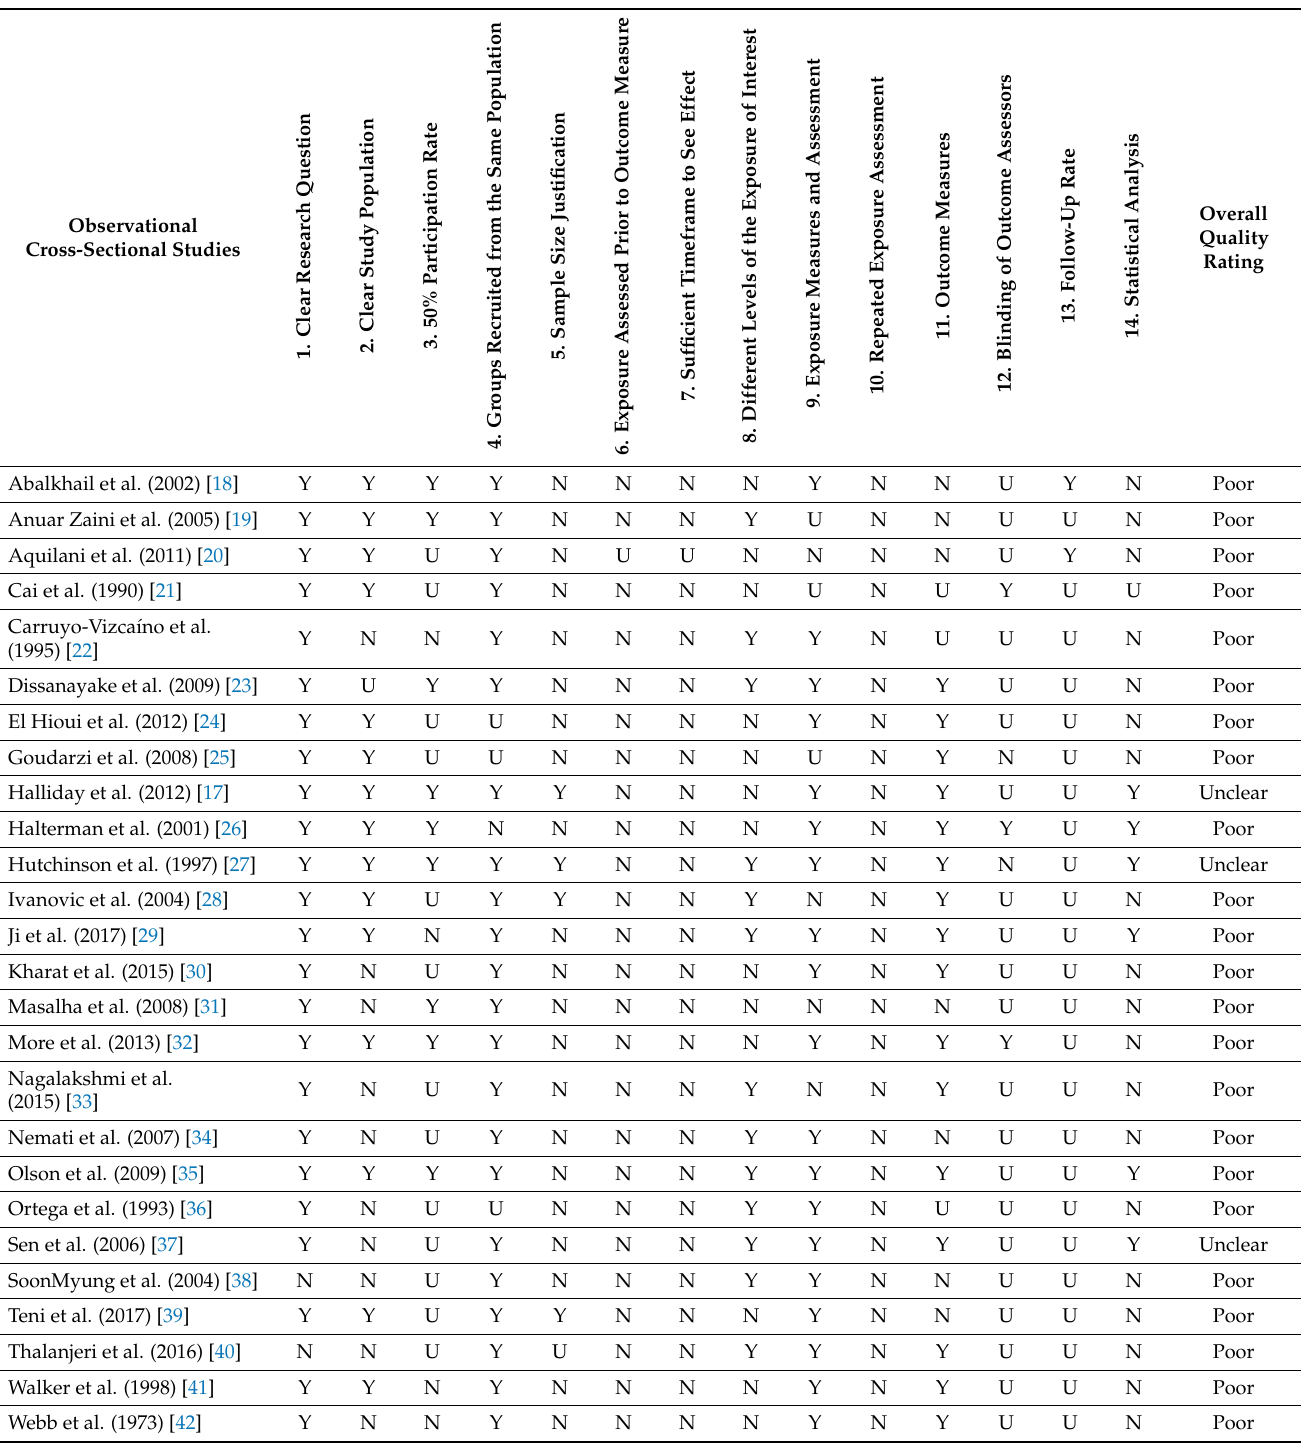
Table 5. Study quality assessment using the NHLBI Quality Assessment Tool for observational cohort and cross-sectional studies that examined iron and dimensions of academic performance and learning